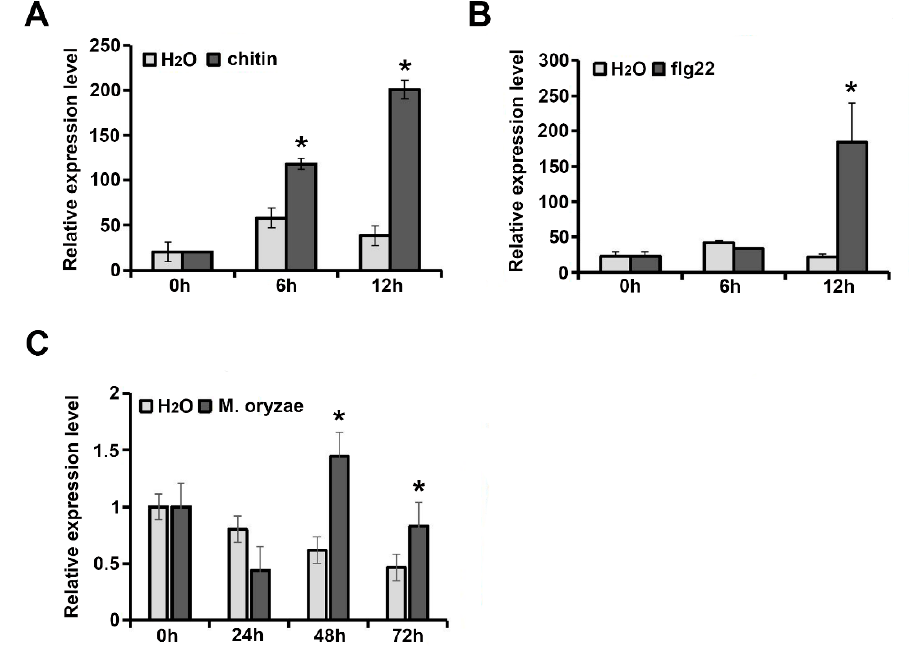
Figure 3. Transcripts of OsExo70B1 are induced by pathogen-associated molecular patterns (PAMPs) and M. oryzae . ( A ) Expression analysis of OsExo70B1 after chitin treatment, with H 2 O set as a control. ( B ) Expression analysis of OsExo70B1 after flg22 treatment, with H 2 O set as a control. ( C ) Expression analysis of OsExo70B1 after M. oryzae inoculation, with H 2 O set as a control. Data represent the mean and standard deviation of three biological replicates. Three technical replicates for each biological sample were used. The asterisk indicates significant differences (* p < 0.05; Student’s t -test).